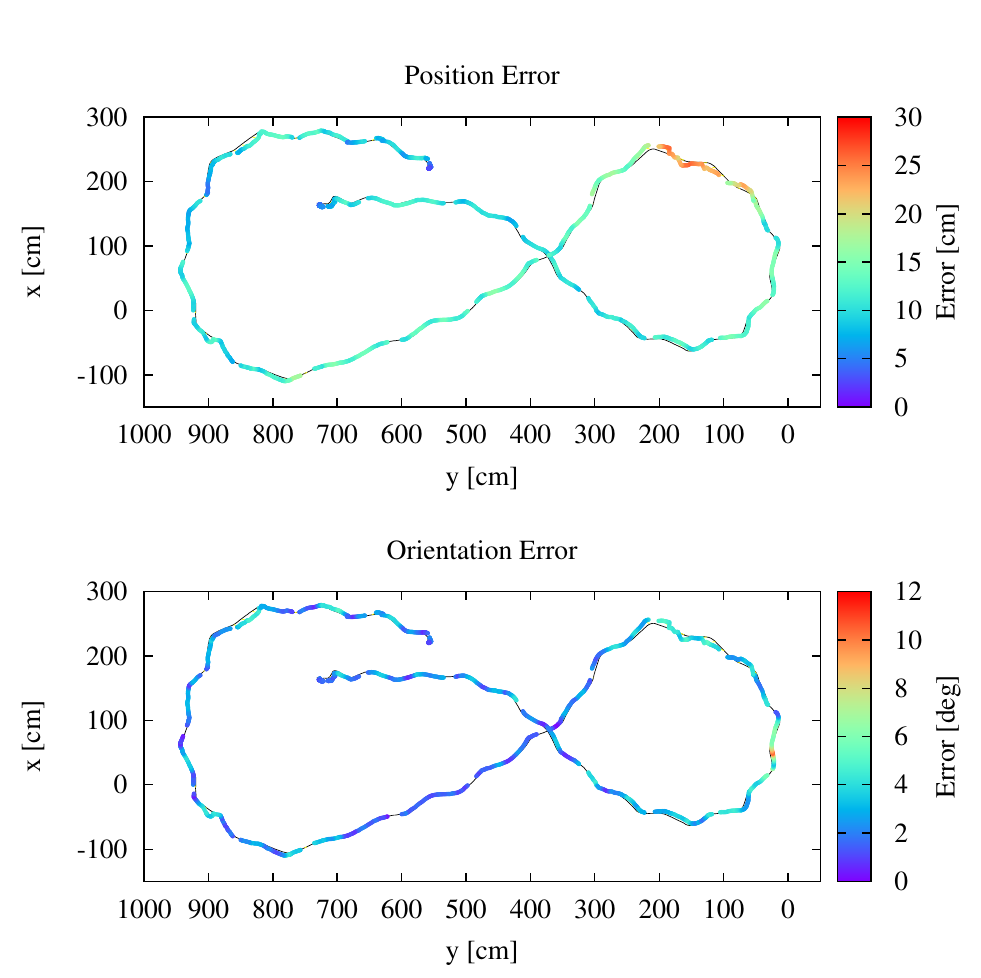
Figure 13. Experiment 1. ( Top ): position error after applying semi-rigid registration. ( Bottom ): orientation error. The black line denotes the ground truth trajectory and the colored points the initial estimated